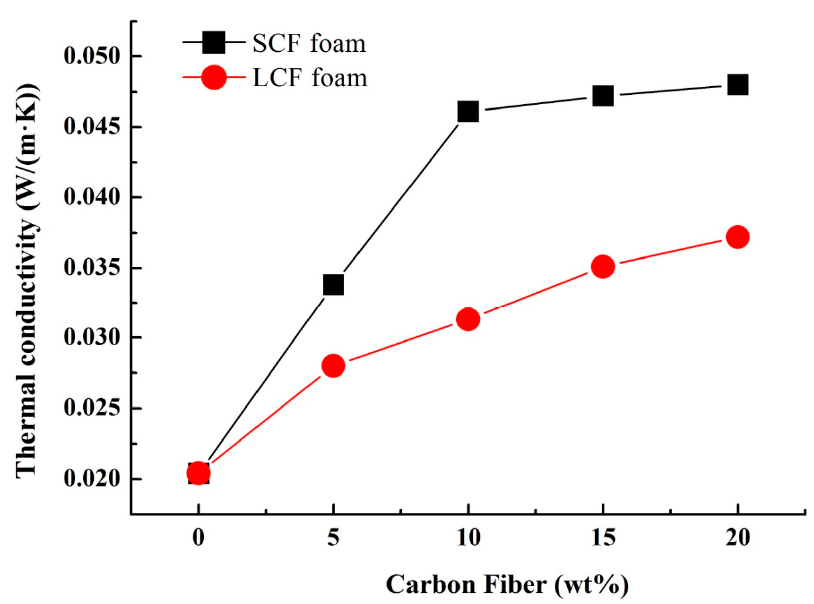
Figure 7. Thermal conductivity of the composite foams.